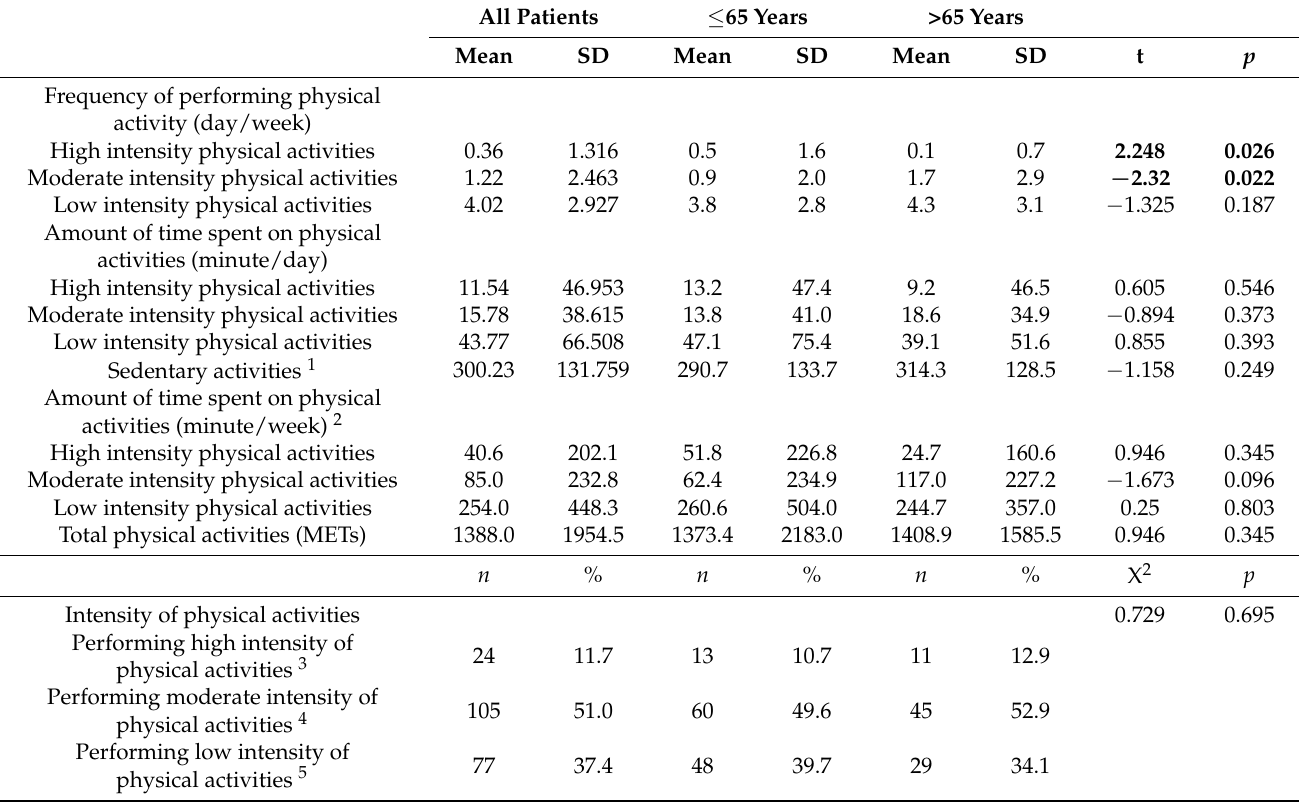
Table 2. Status of Daily Physical Activities in Younger ( ≤ 65 Years) and Older (>65 Years) Patients with